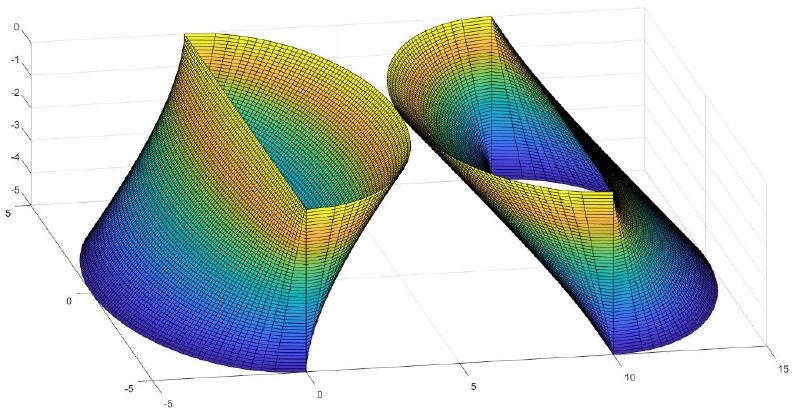
Figure 37. Two parallel Pterasphera tubules.